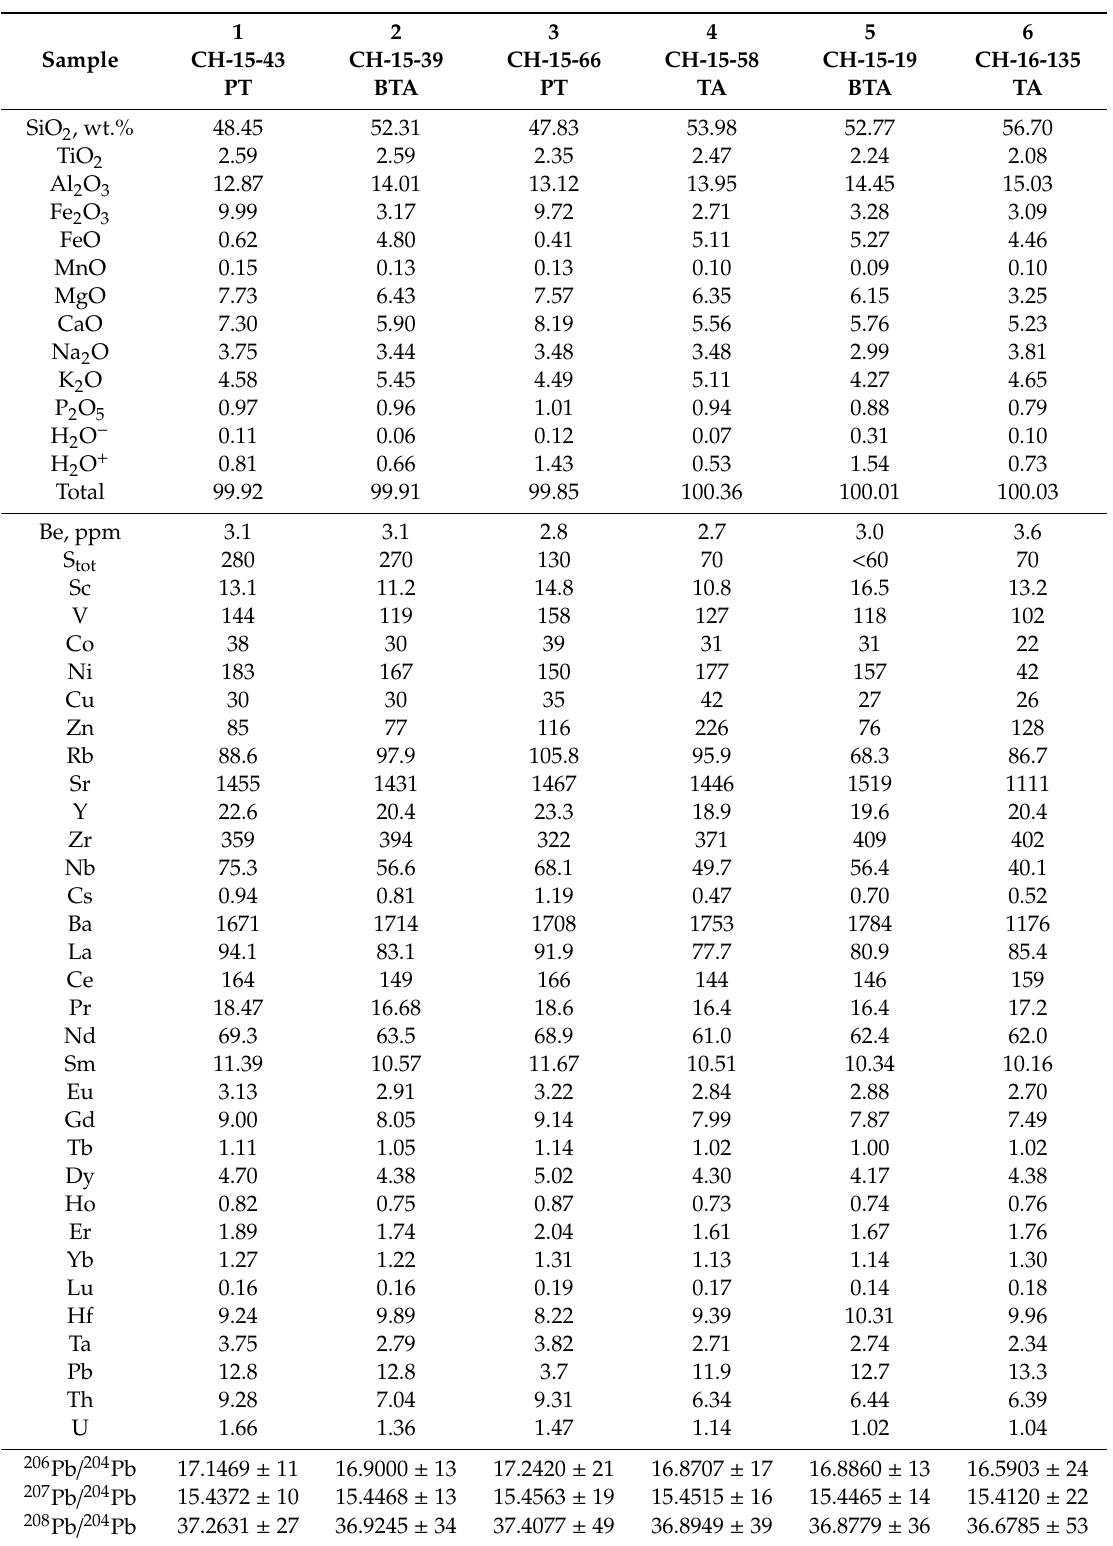
Table 2. Representative data of volcanic